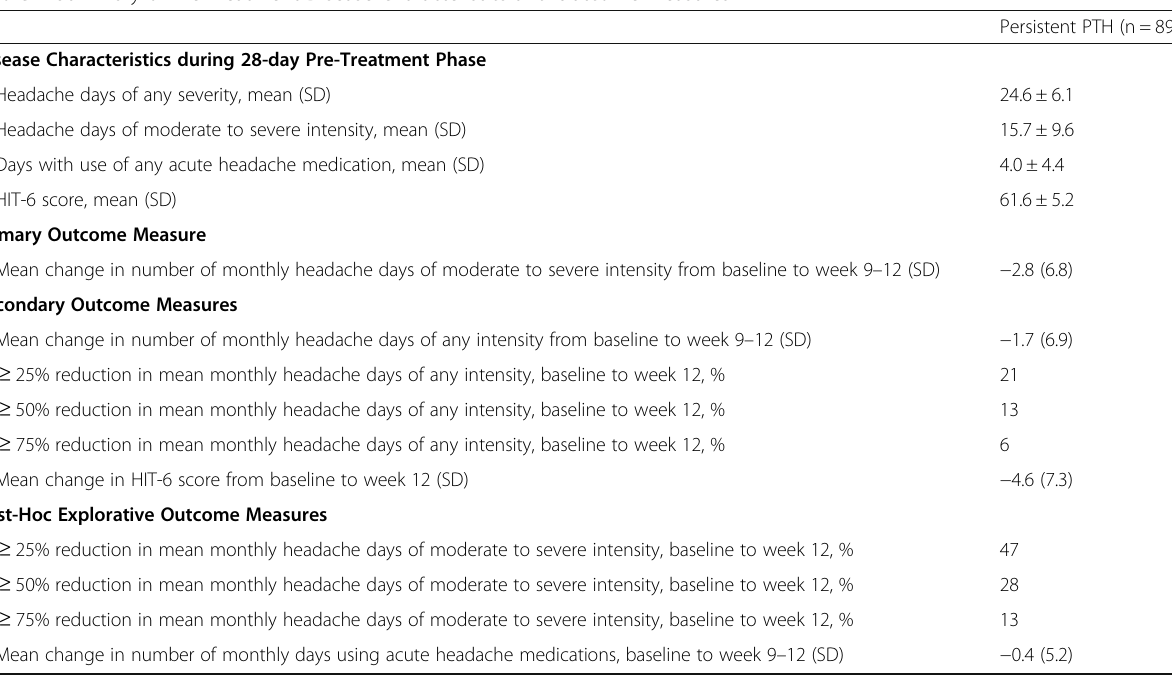
Table 2 Summary of Pre-Treatment Disease Characteristics and Outcome